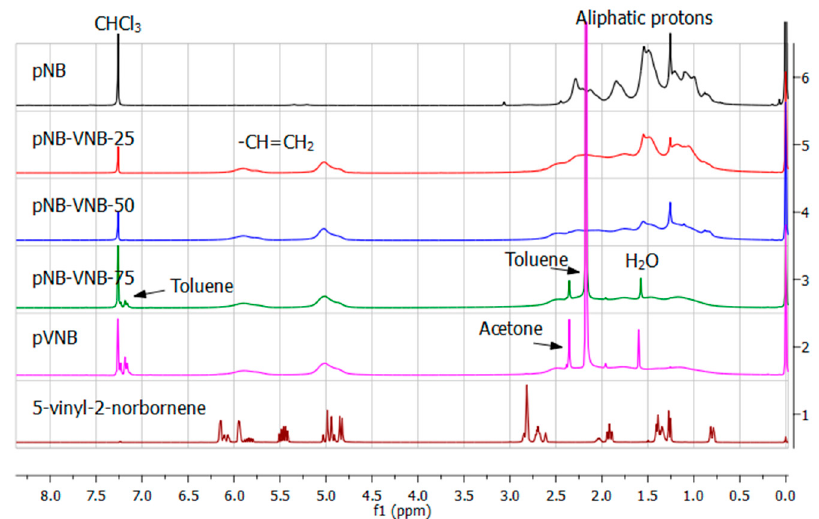
Figure 2. 1 H NMR spectra, from top to bottom, of pNB, pNB-VNB-25, pNB-VNB-50, pNB-VNB-75, pVNB and the monomer VNB. Residual solvent signals from work up are marked in spectra of less soluble pNB-VNB-75 and pVNB.